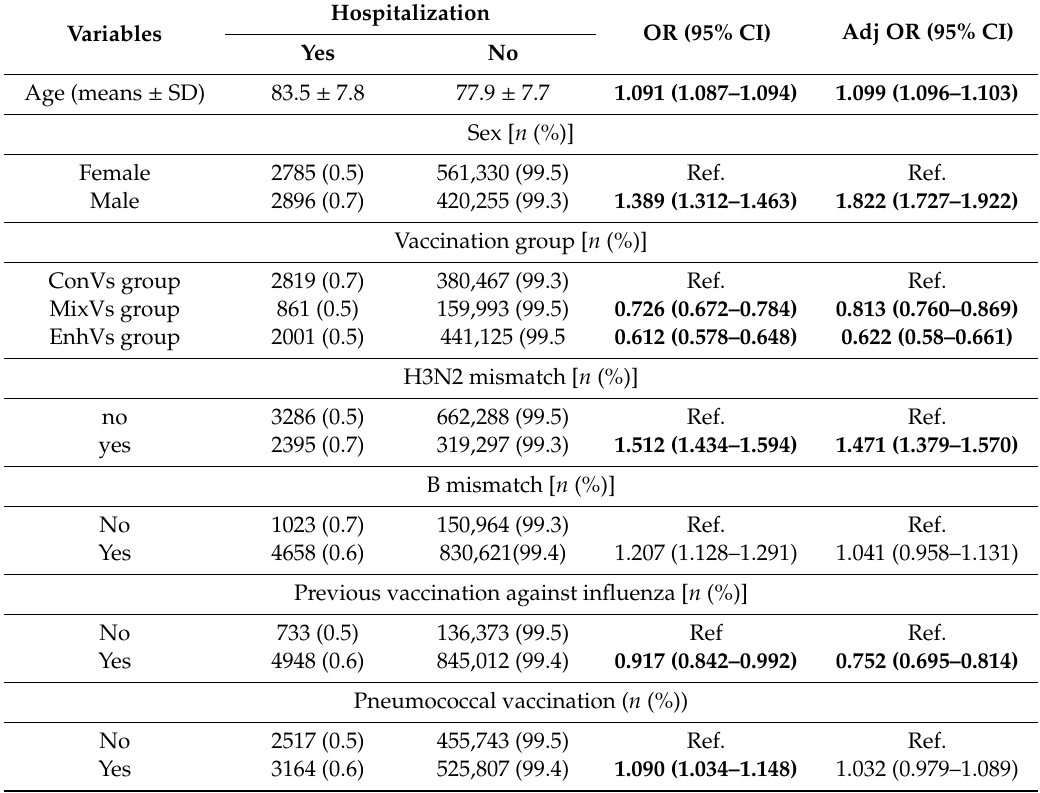
Table 2. Distribution of the characteristics of the sample by need for hospital admission for pneumonia.